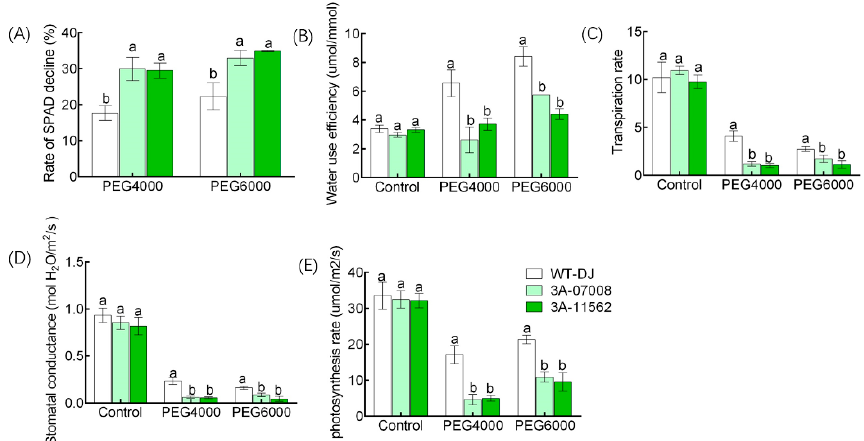
Figure 6. Physiological parameters of ostbp2.2 and WT-DJ. Four-week-old rice of ostbp2.2 and WT-DJ were cultivated one week under normal solution, 15% PEG4000 and 15% PEG6000. Rate of SPAD decline ( A ), water use efficiency ( B ), transpiration ( C ), stomatal conductance ( D ) and photosynthesis rate ( E ) were assayed. SPAD, the relative content of chlorophyll. Error bars: SE ( n = 5). Significant differences between ostbp2.2 and WT-DJ are indicated by different letters. ( p < 0.05).